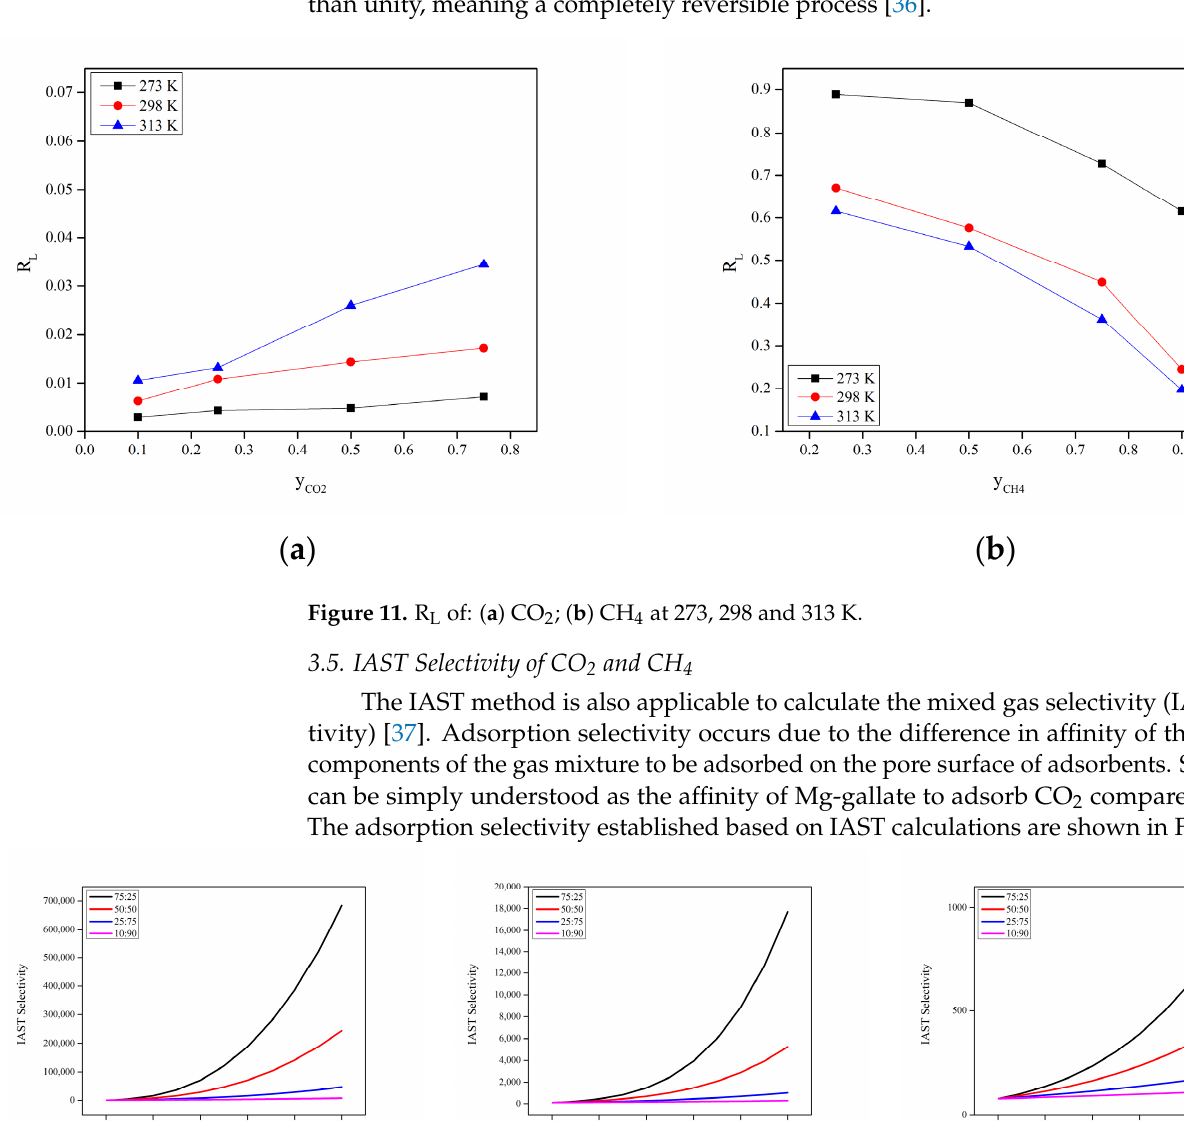
Figure 12. IAST selectivity of CO 2 and CH 4 at: ( a ) 273 K; ( b ) 298 K and ( c ) 313 K, respectively.